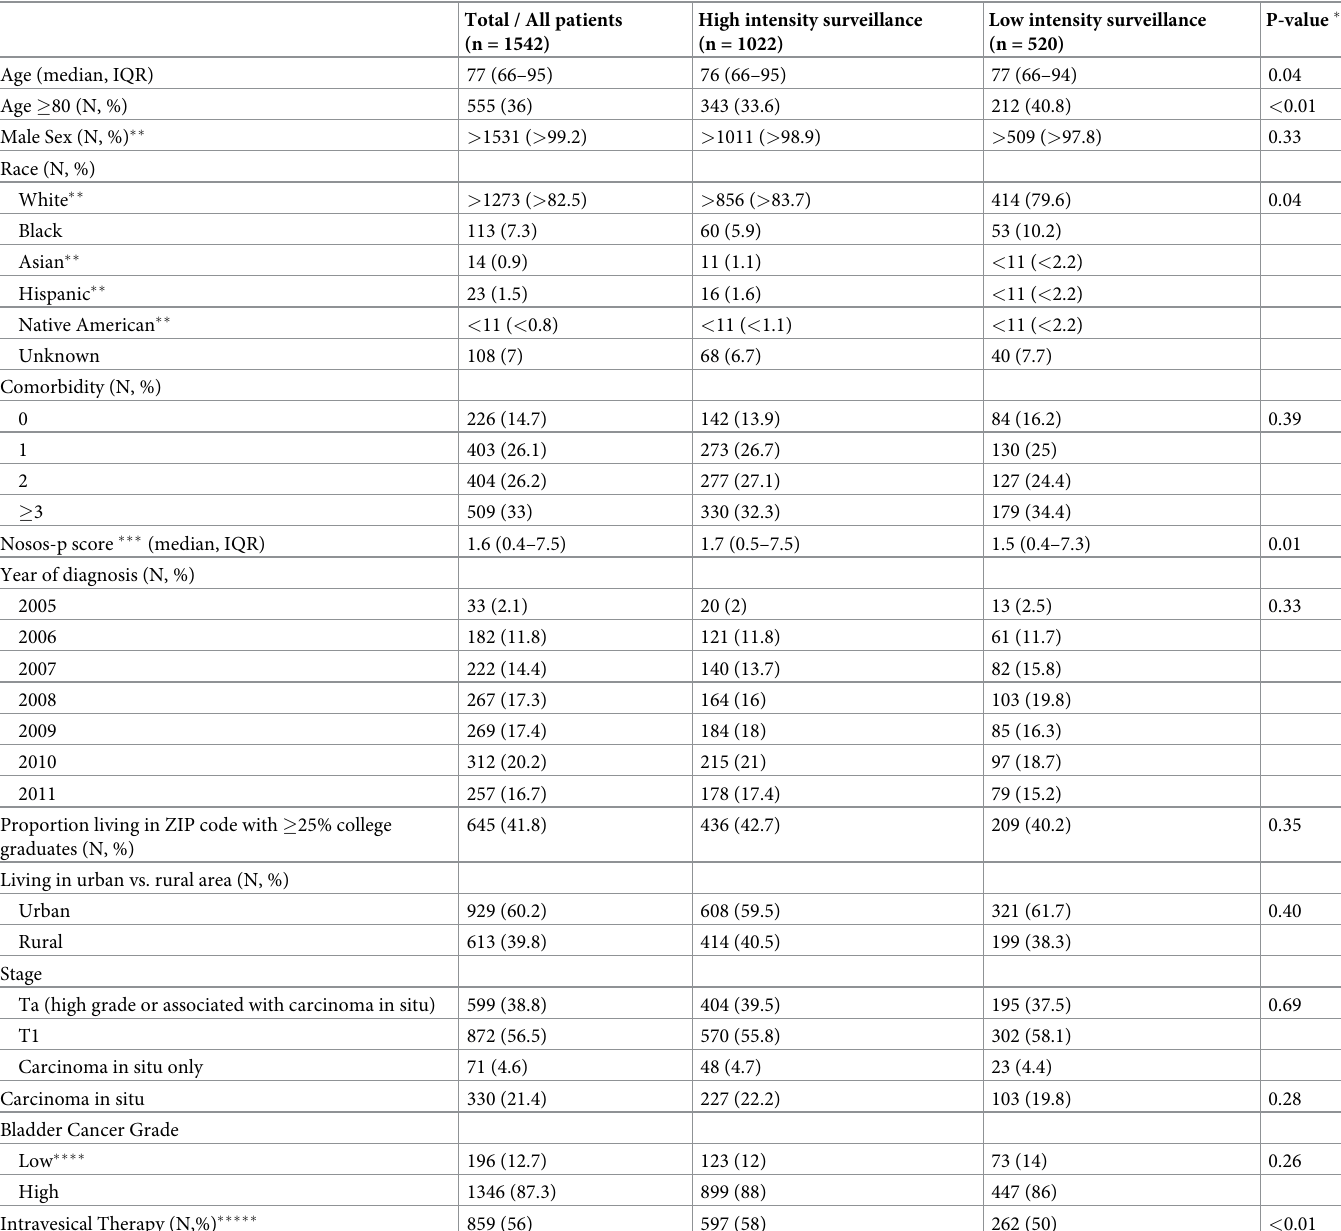
Table 1. Baseline patient characteristics of 1,542 patients diagnosed with high-risk NMIBC stratified by low versus-high intesity cystoscopic